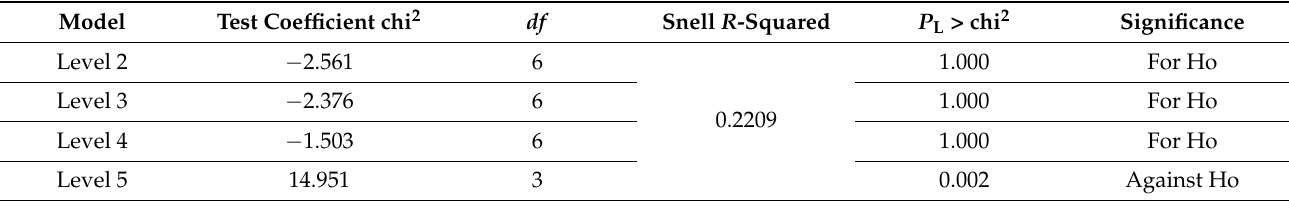
Table 8. Hausman test result of the prediction